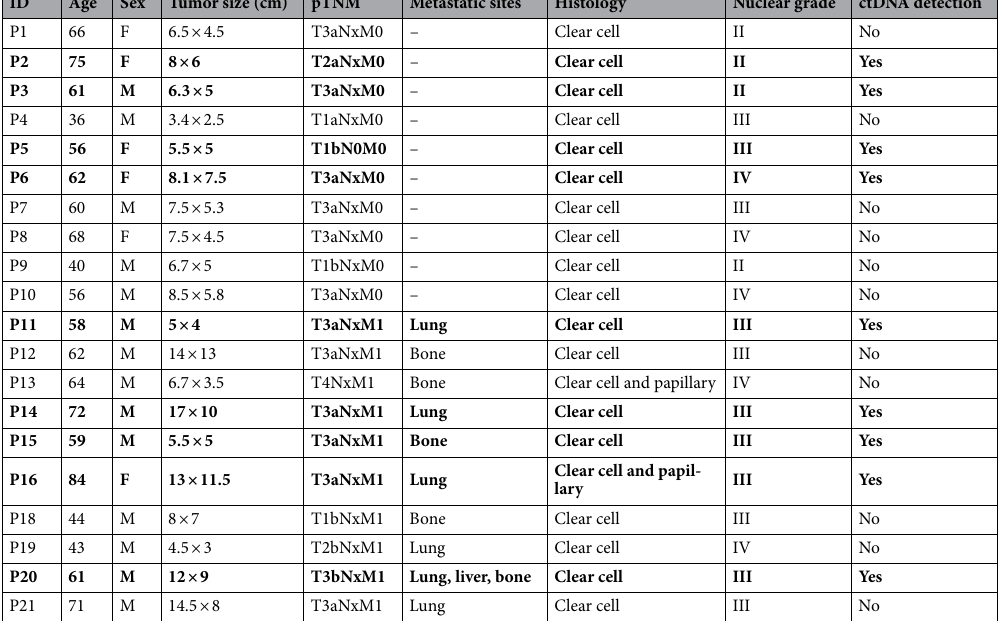
Table 1. Clinicopathological data of 20 patients with renal cell carcinoma with and without metastasis. P17 was omitted from the study due to follow-up loss after surgery. Bold marks refer to patients with ctDNA detected in their plasma by targeted deep